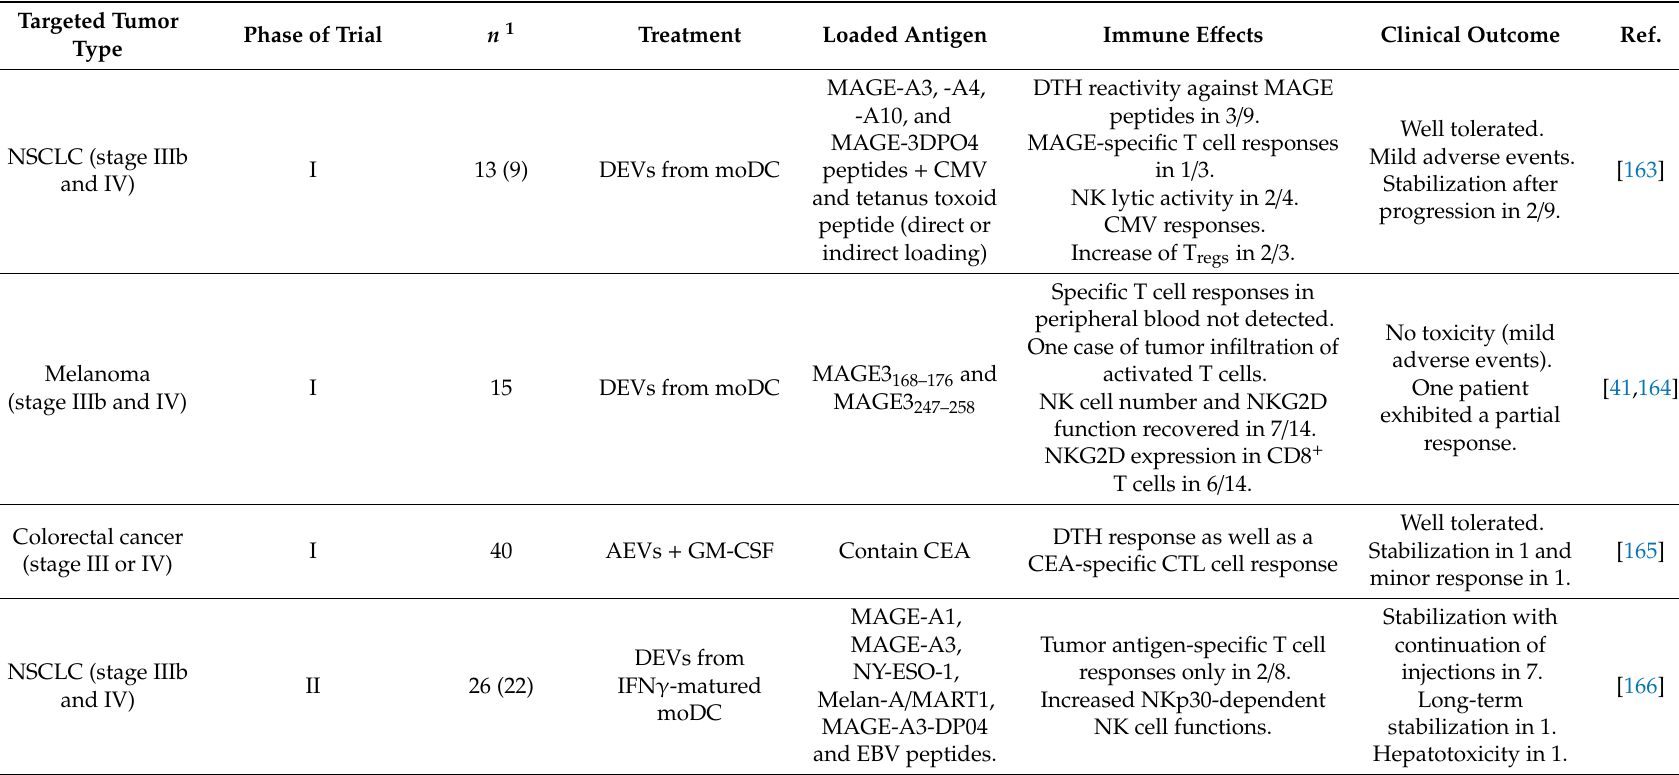
Table 1. Clinical trials using DEVs performed to date and their main immune and clinical